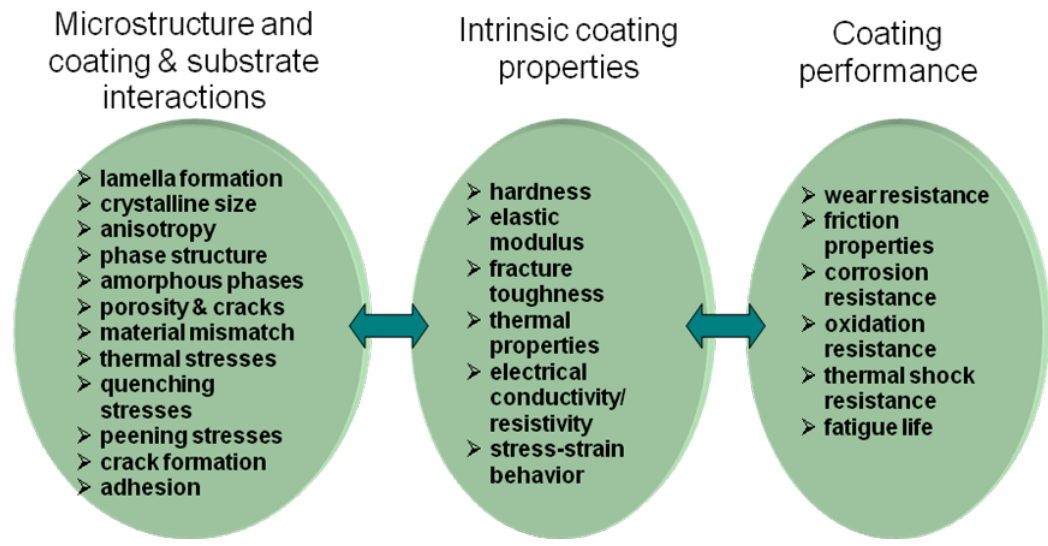
Figure 10. A typical optimization route of coating performance by controlling the intrinsic coating properties via optimization of coating microstructure and coating/substrate system